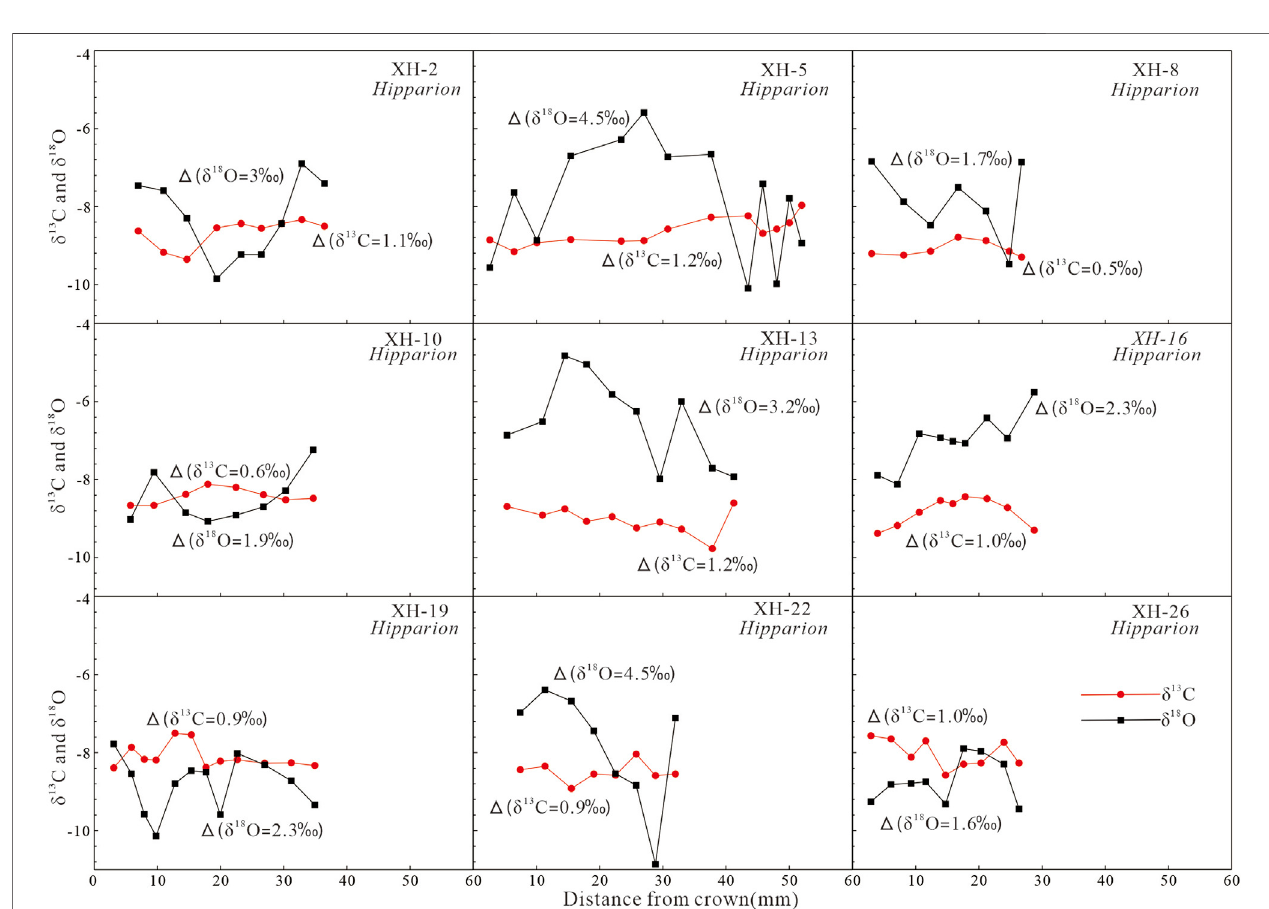
FIGURE 5 | Intra-tooth isotopic variations in selected Hipparion teeth from Xunhua Basin. Δ 13 C and Δ 18 O values indicate the range of carbon and oxygen isotopic variations, respectively, within each tooth.